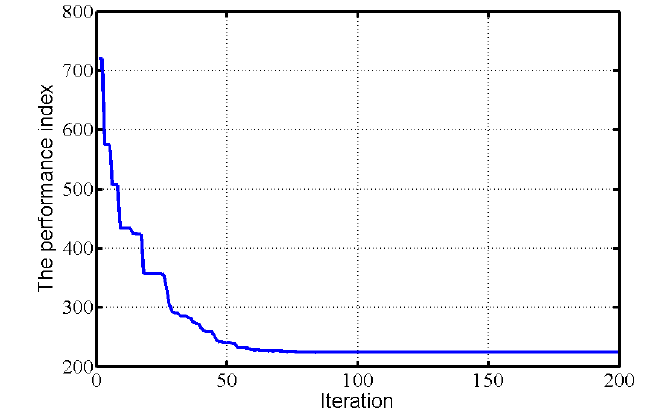
Figure 18. Evolutionary curve of the performance index for FOPID controller without